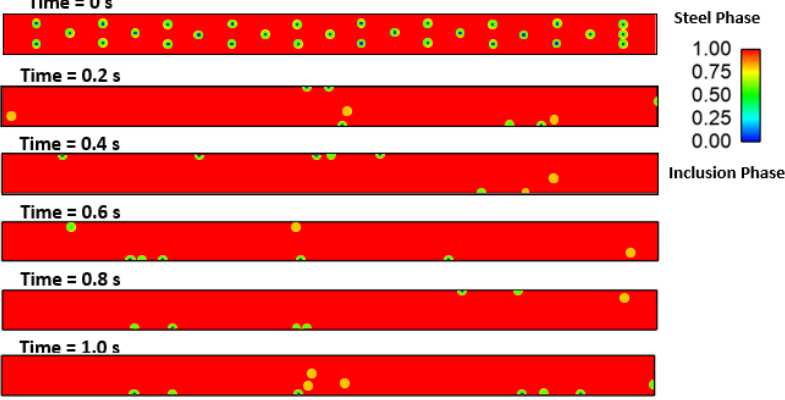
Figure 6. Motion of alumina inclusion during solidification (initial temp: 1893 K, sulfur: 10 PPM).